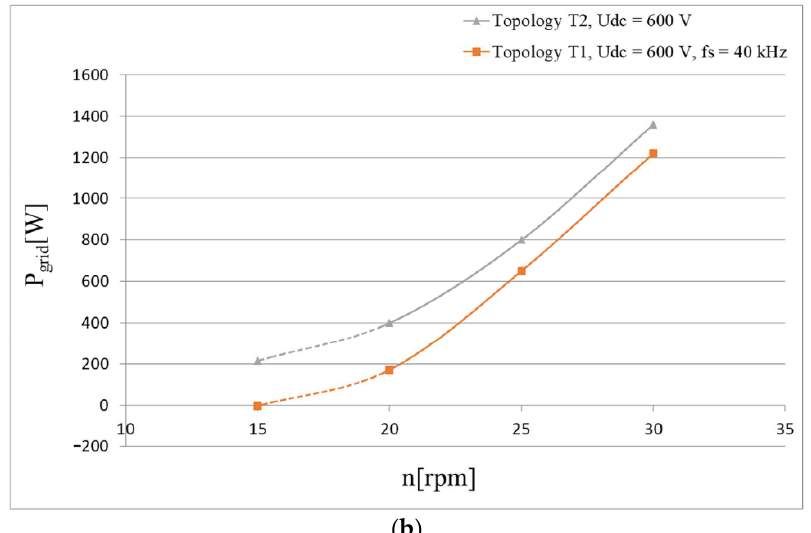
Figure 7. Power transmitted to the grid at maximum power generated in the generator for different generator speeds for the two converter topologies: ( a ) T1 and T2 (15.3 A, U dc = 600 V) and ( b ) a zoomed-in section of the waveform at turbine speeds below 30 rpm.